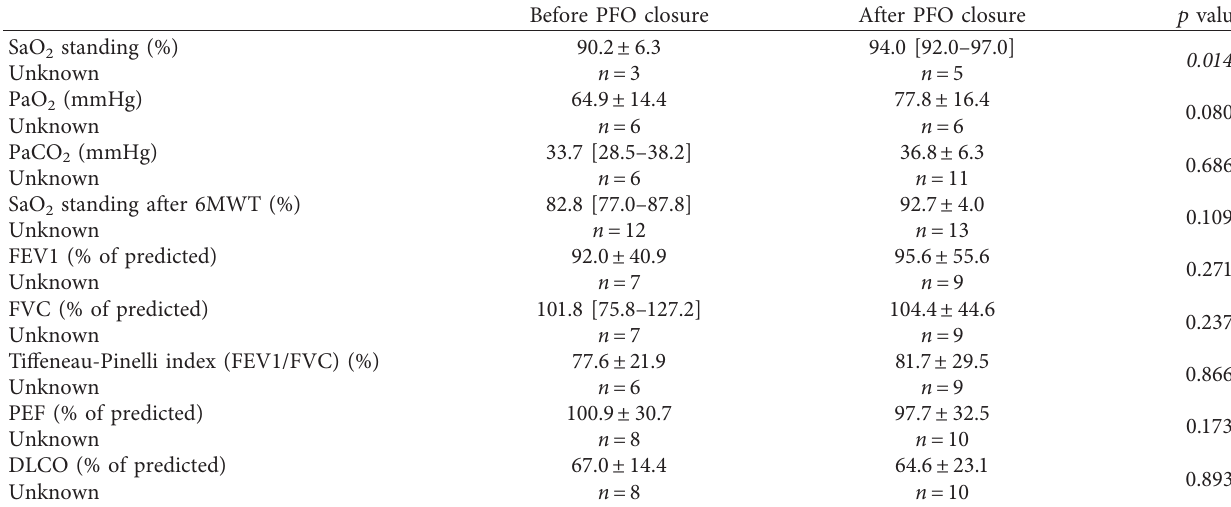
Table 4: Pre- and postprocedural parameters.